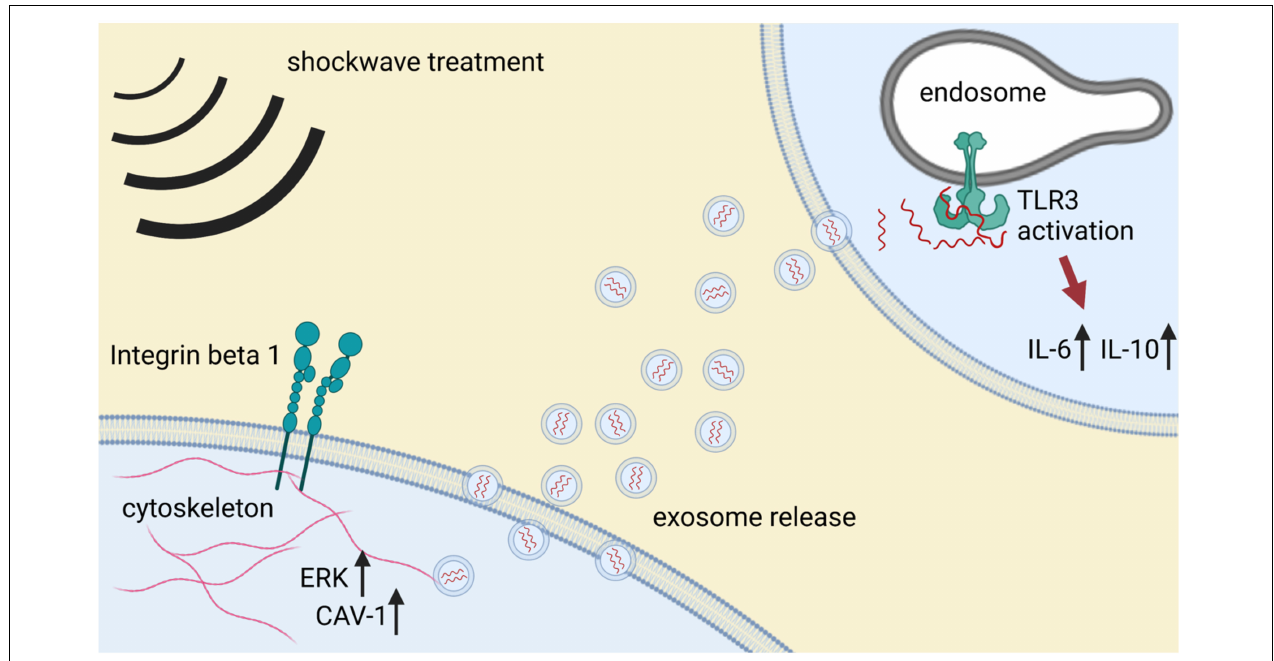
FIGURE 2 | Mechanotransduction and modulation of inflammatory response upon SWT. Mechanical stimulation with shockwaves induces cellular mechanosensing. Activation of beta 1 integrin on the cell surface induces intracellular upregulation of ERK, which in turn activates caveolin 1 (CAV-1). Caveolin is a potent regulator of microvesicle release and hence, intercellular communication. Microvesicles, particularly exosomes, are loaded with specific cargo and released to the extracellular space. Uptake of shockwave-derived exosomes activates the innate immune receptor TLR3. TLR3 signaling results in an inflammatory response that may induce epigenetic alterations required for the regenerative effects of